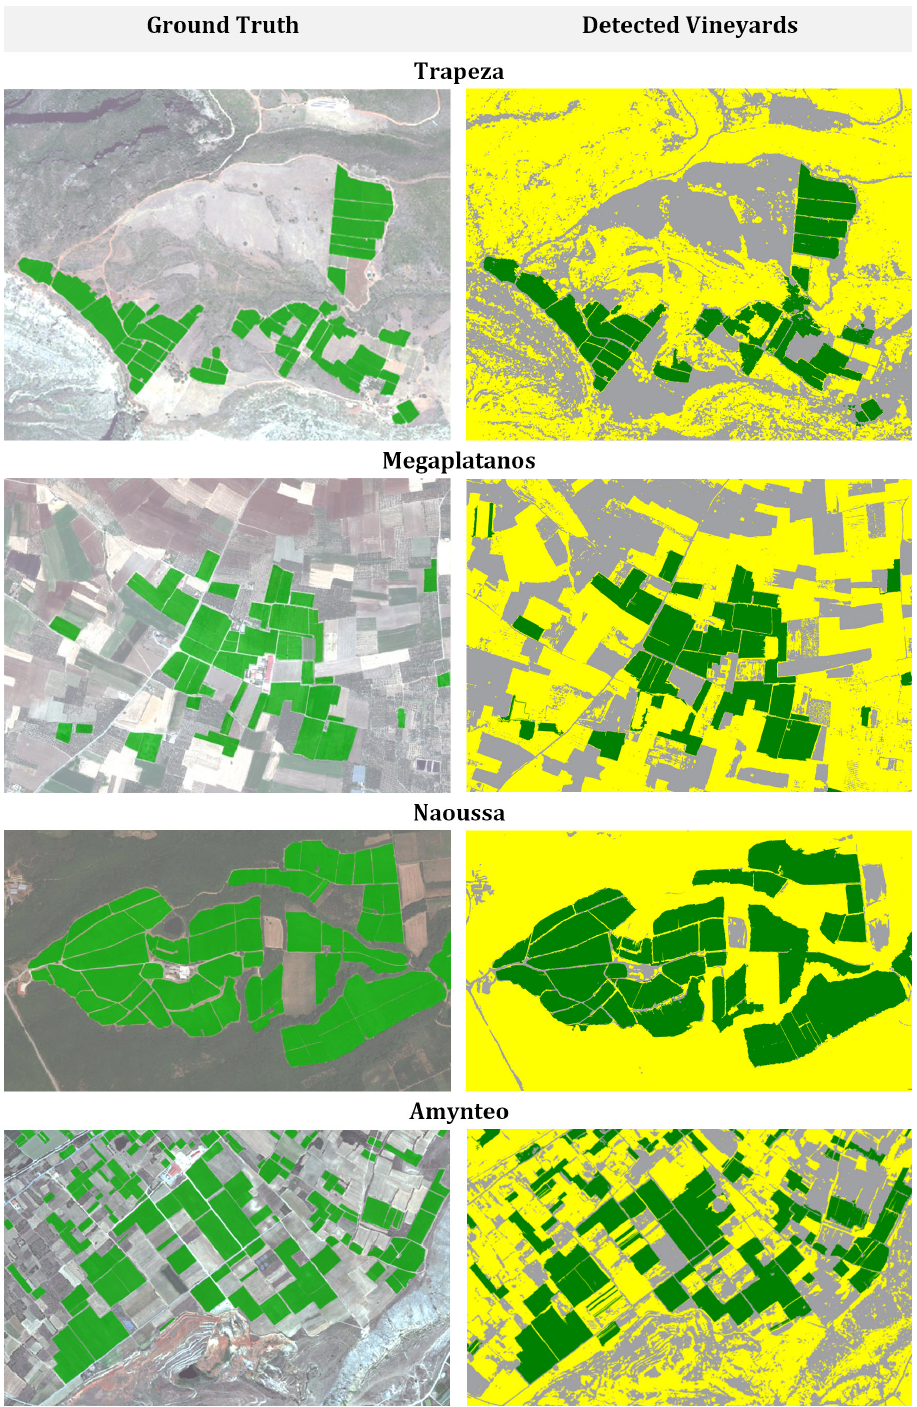
Figure 3. Experimental results after the application of the developed vineyard detection methodology. The detected vineyards (with green color) and the ground truth are shown for all study areas. The Other-Vegetation class is presented with yellow